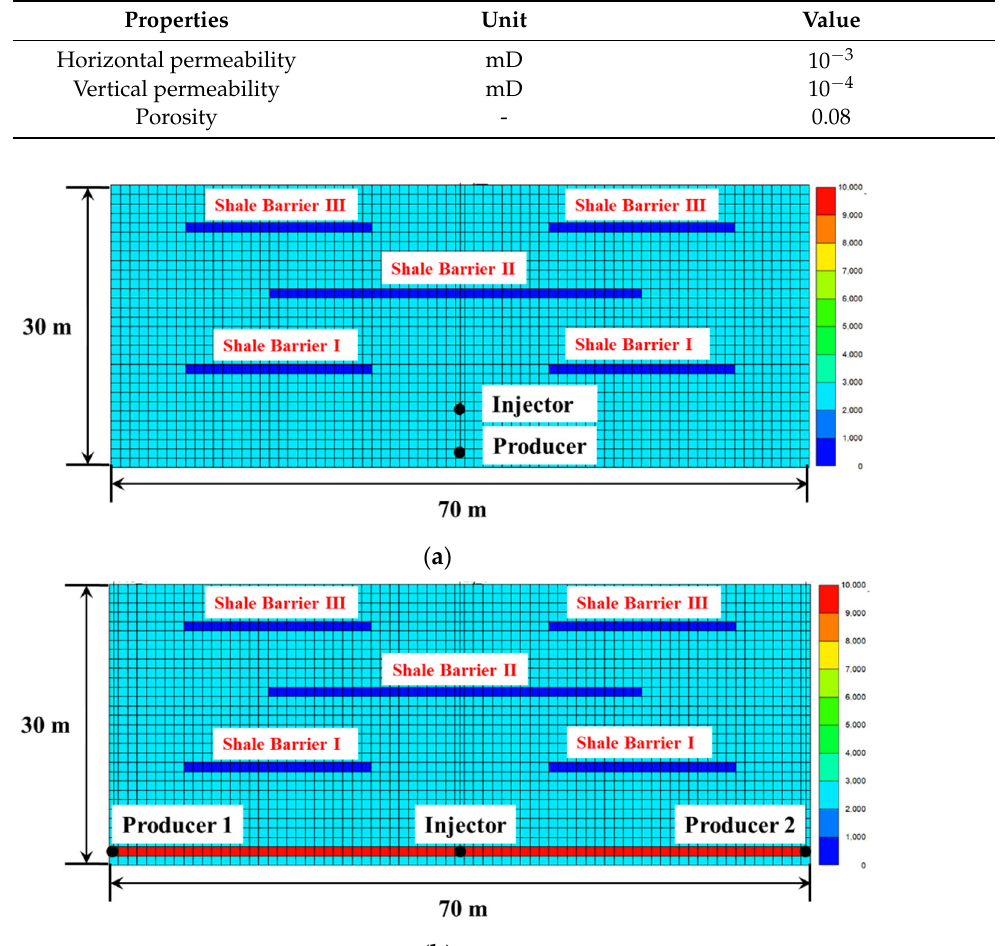
Figure 3. Schematic of the grid systems in ( a ) the SAGD process and ( b ) the bottom-up assisted SAGD process with respect to the well locations and shale barriers distribution.